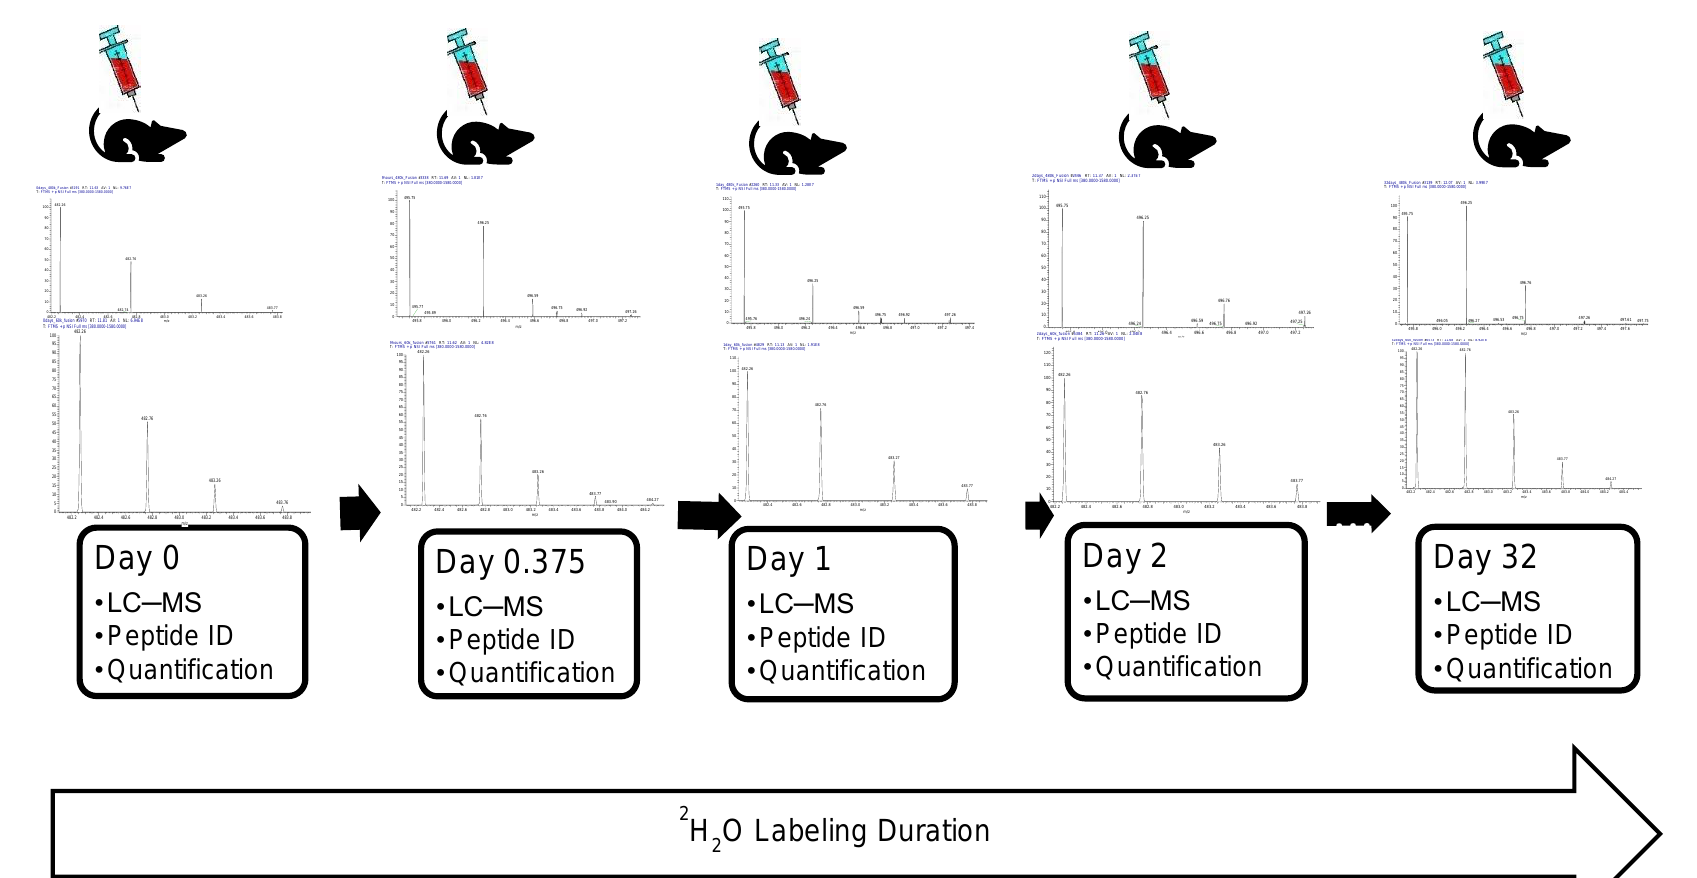
2 H O Labeling Duration 2